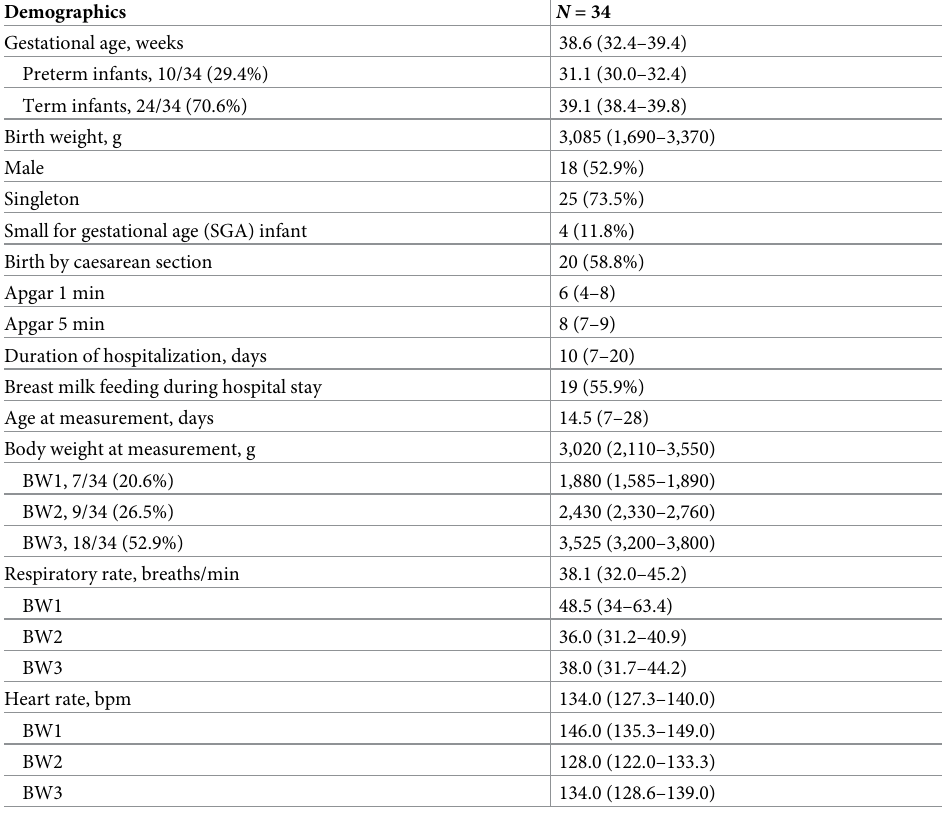
Table 1. Baseline characteristics of the